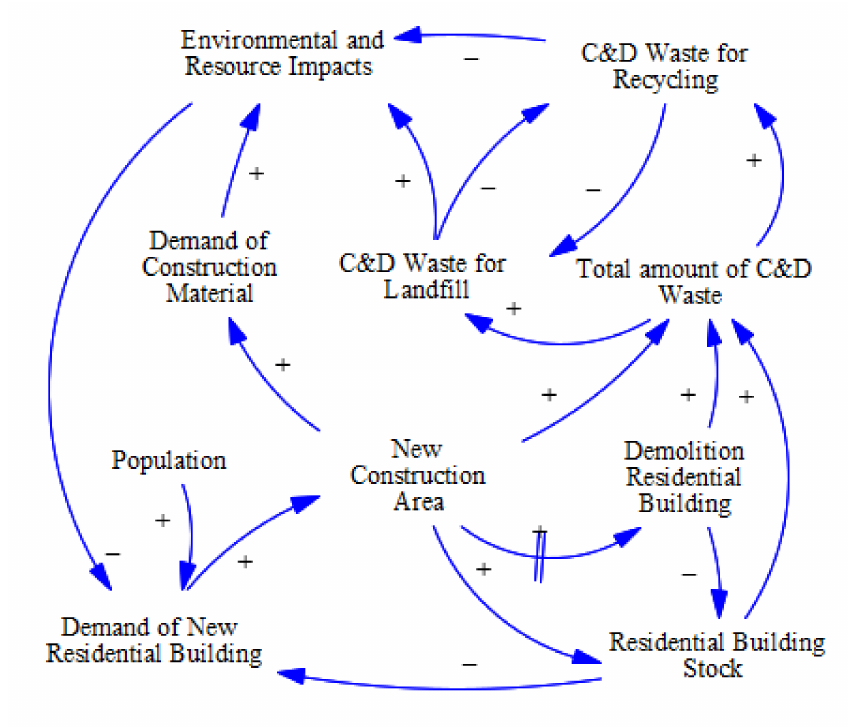
Figure 1. Causal loop diagram of the urban residential building